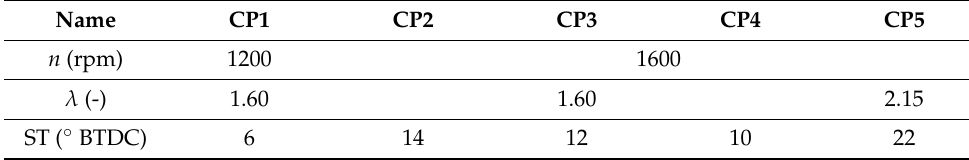
Table 4. Details of calibration operating points with initial pre-chamber design.